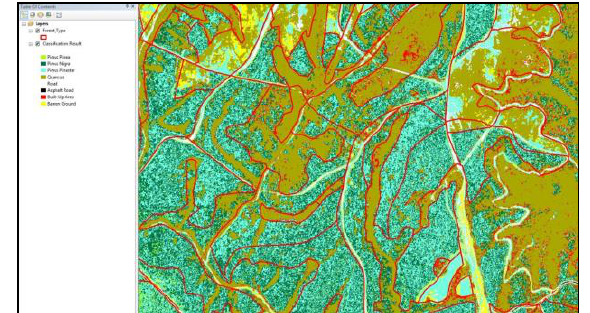
Fig.3. Results of pixel-based classification of Pleiades spectral